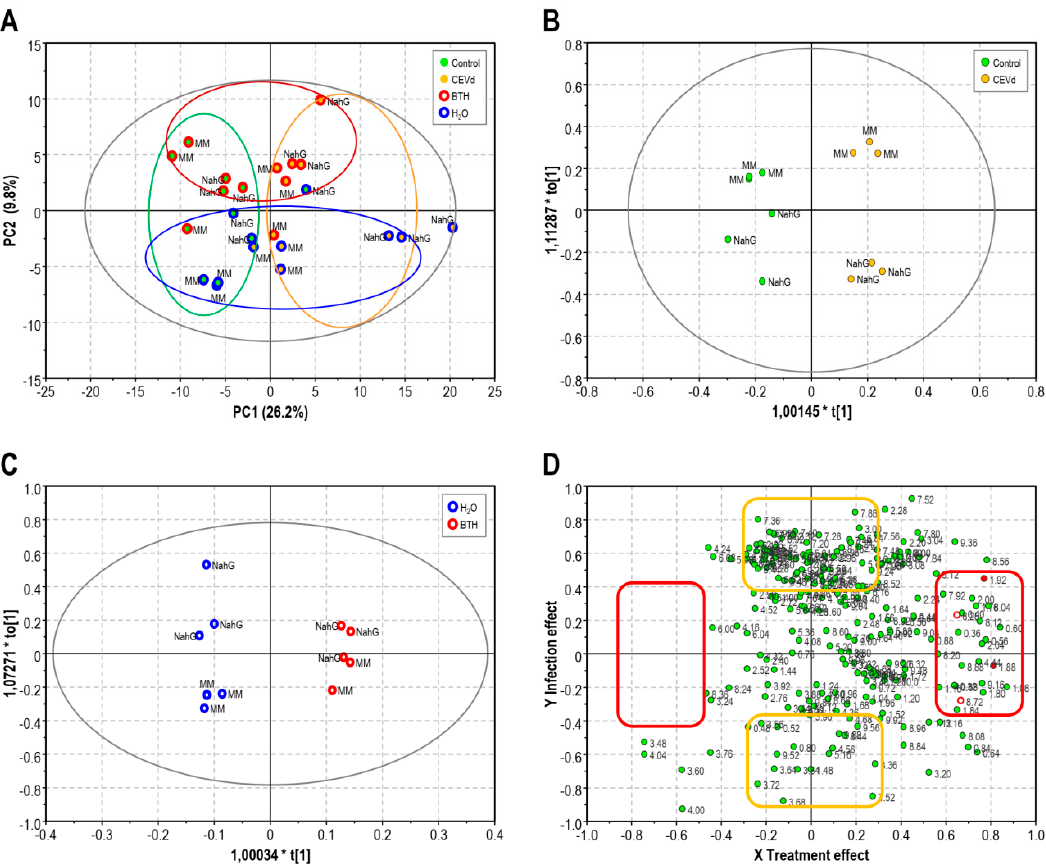
Figure 2. Multivariable data analysis based on the 1 H-NMR signals, in the range of 0.3–10.0 ppm, of the Money Maker (MM) and NahG tomato plants after viroid inoculation and BTH treatments at 3 weeks post infection (green; mock tomato leaves, yellow; tomato leaves infected by CEVd, red; leaves after BTH treatments blue; leaves after H 2 O treatments). ( A ) Score plot of partial least square (PLS) ( B ) Score plot of orthogonal projection to latent structures-discriminant analysis (OPLS-DA) of the infection ( R 2 = 0.95, Q 2 = 0.82). ( C ) Score plot of OPLS-DA of chemical treatment ( R 2 = 0.99, Q 2 = 0.93). ( D ) Shared-and-unique-structures (SUS) plot correlating the two OPLS-DA models with the Y axis as CEVd infection and X axis as BTH treatment ( 1 H-NMR signals of GABA in red full circles and 1 H-NMR signals of hydrolyzed BTH in red open circles).